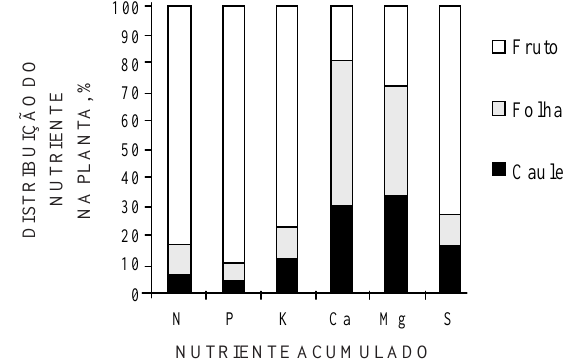
Figura 4. Distribuição percentual dos nutrientes acumulados na parte aérea do pimentão (caule, folhas e frutos), após 34 semanas de cultivo em ambiente protegido e aplicação de N e K ao